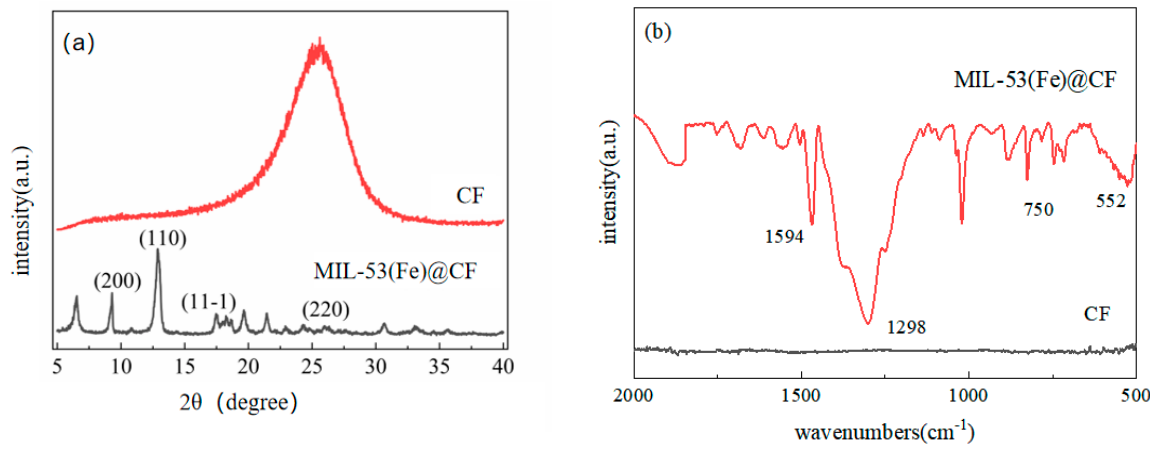
Figure 2. MIL-53(Fe) @CF in situ growth of XRD ( a ) and FT-IR ( b ). FT-IR analysis was used to determine the structure of the MIL-53(Fe)@CF (Figure 2b). The FT-IR was measured at a wavelength of 400 cm − 1 to 4000 cm − 1 , but only the